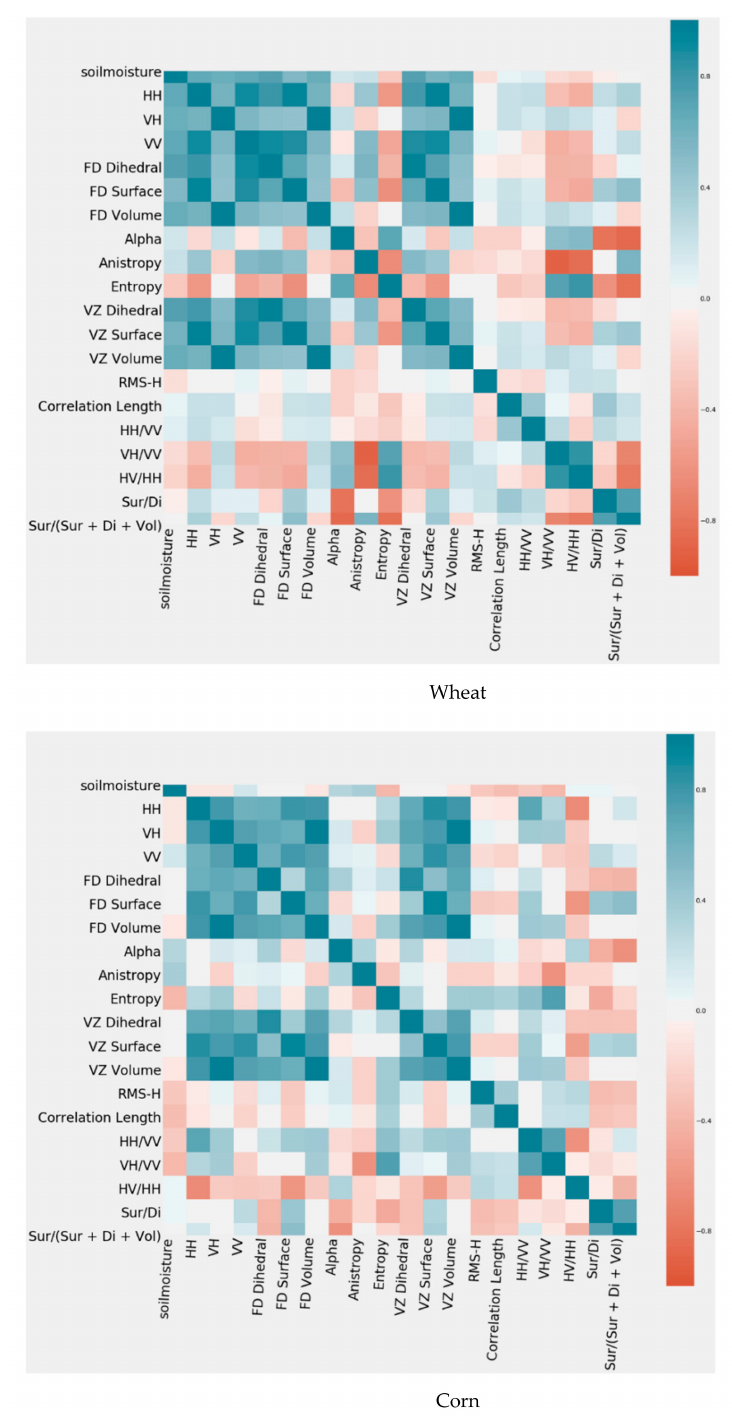
Figure 3. Correlation matrixes for soybeans, wheat, and corn. These correlation matrixes docu- ment the correlation between soil moisture and polarimetric features, and the correlation between polarimetric features. HH = transmits and recieves Horizontal Polarization; VH = transmits Ver- tical and recieves Horizontal Polarization; VV = transmits and recieves Vertical Polarization; FD Dideral = Freeman Decomposition Dihedral scattering; FD Surface = Freeman Decomposition Sur- face scattering; FD Volume = Freeman Decomposition Volume scattering; VZ Dideral = van zyl Decomposition Dihedral scattering; VZ Surface = van zyl Decomposition Surface scattering; VZ Volume = van zyl Decomposition Volume scattering; Sur = Surface Scattering; Di= Dihedral scattering; Vol = Volume